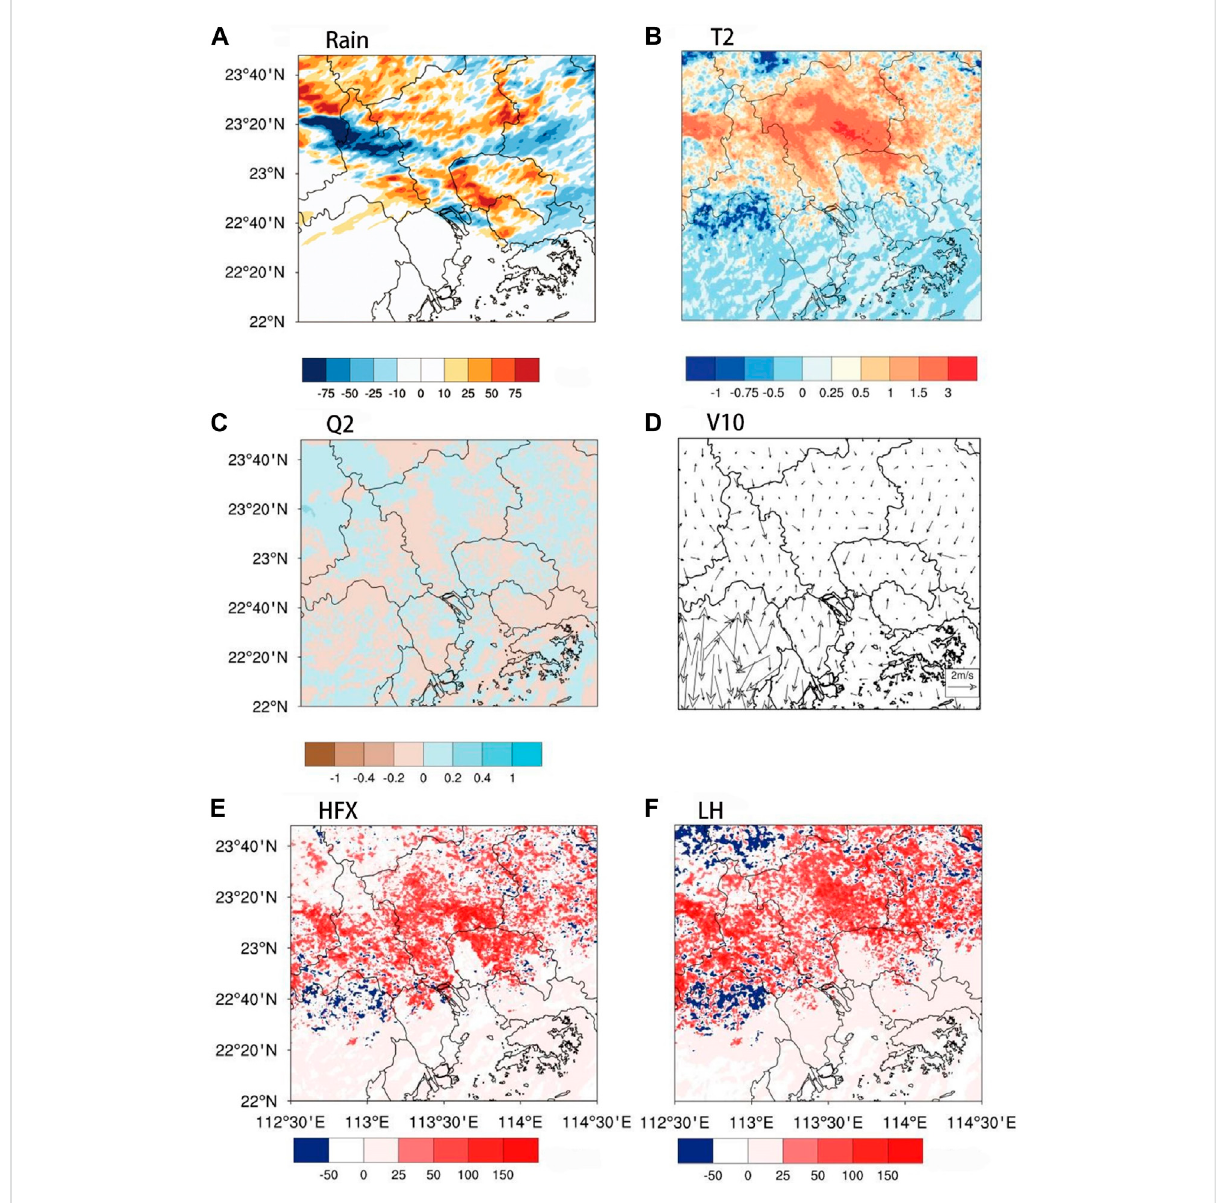
FIGURE 9 Similar to Figure 7 but for the difference between the Urb5w-5ah and Urb5w experimental